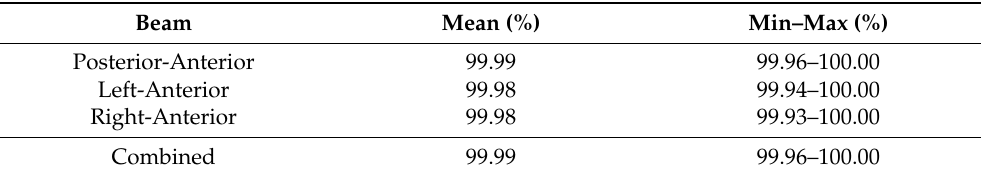
Figure 9. Difference between contours propagated to the standard-protocol CT (vCT STD ) and the lowest-dose CT (vCT LOW ) for the high-risk CTV (HR-CTV) and low-risk CTV (LR-CTV). Table 3. Mean and min–max 2%/2 mm gamma pass rates calculated in the low-dose CT volumes (CTDI vol = 4.2 mGy) using the standard-protocol CT volume as